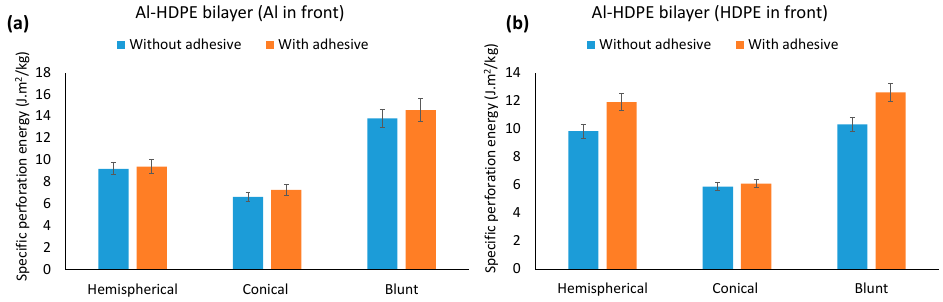
Figure 16. Comparison of perforation energy with and without adhesive for ( a ) when Al faced the indenter and ( b ) when HDPE faced the indenter in Al–HDPE bilayers.